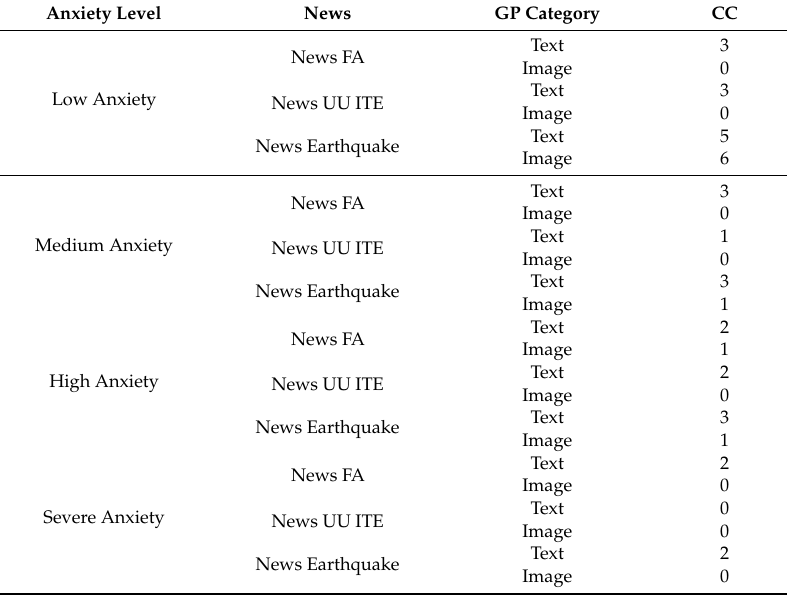
Table 24. Relationship between anxiety level, news, and gaze preference